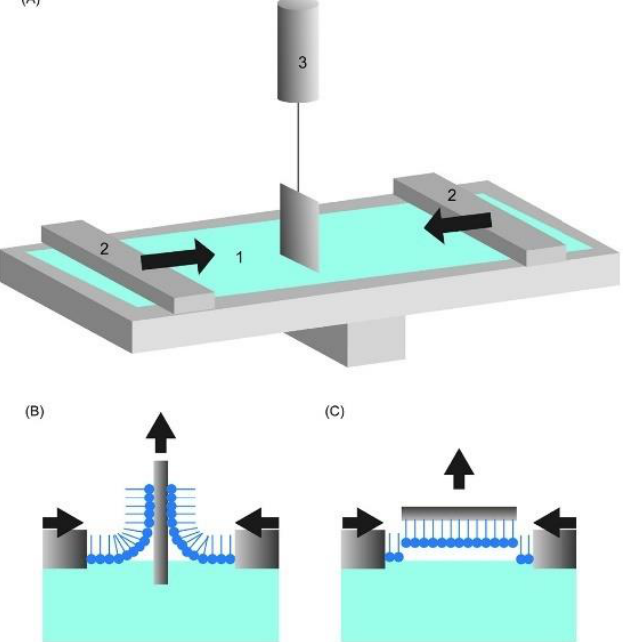
Figure 4. ( A ) Scheme of a Langmuir film balance fitted with a contact probe (Wilhelmy plate) and two symmetric barriers. The numbers indicate: 1. Fluid interface, 2. Symmetric barriers and 3. Force balance fitted with a Wilhelmy plate. ( B ) Scheme of the vertical transference of a film from a fluid interface to a solid substrate following the Langmuir – Blodgett method. ( C ) Scheme of the horizontal transference of a film from a fluid interface to a solid substrate following the Langmuir – Schaefer method. Reprinted from Wang et al. [67] , with permission from Elsevier, Copyright 2020.